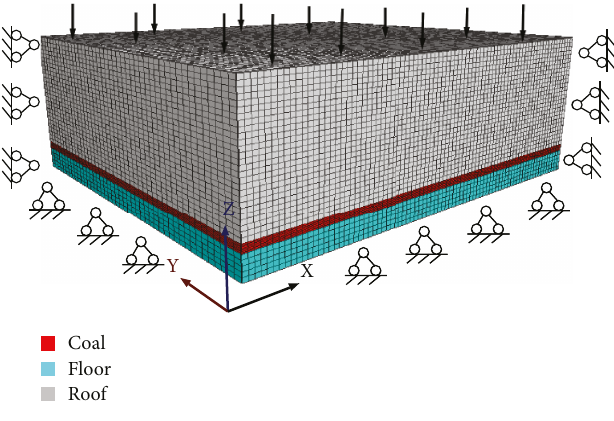
Figure 5: The computational